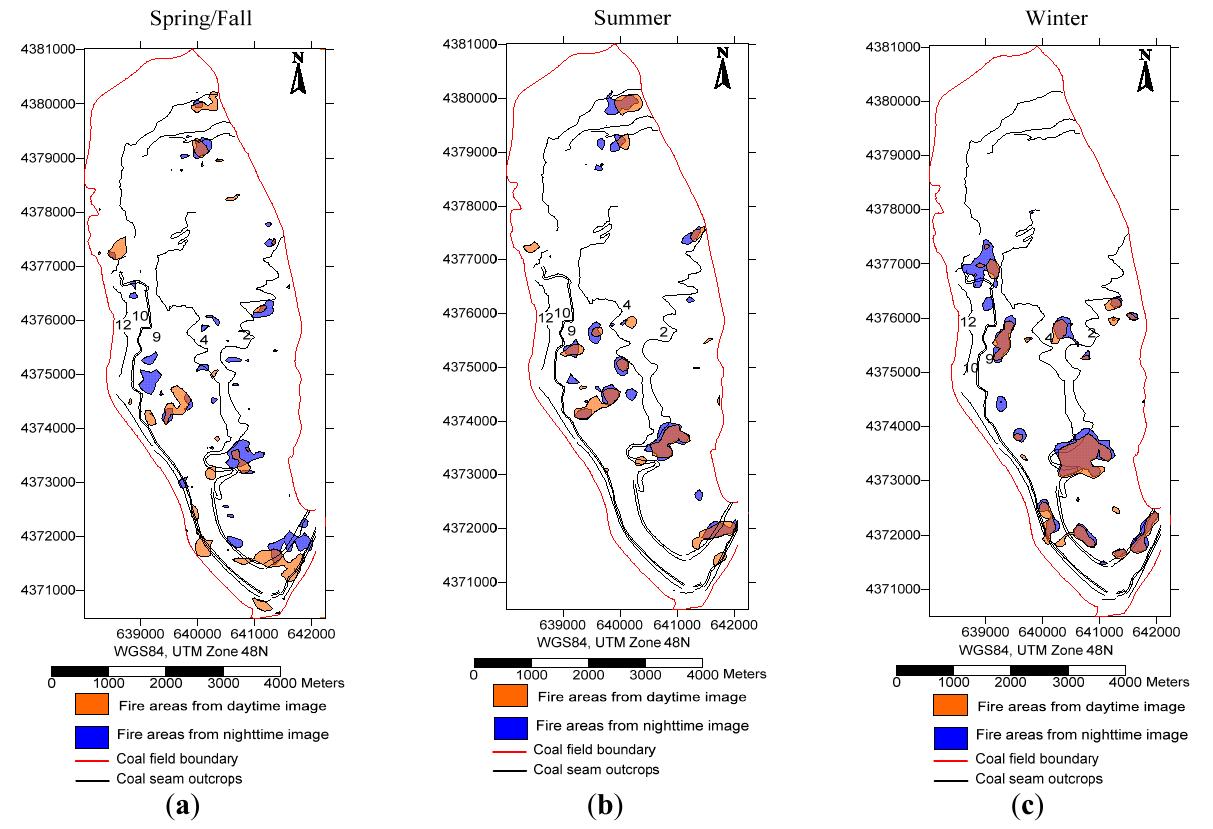
Figure 14. Coal fire areas retrieved from images acquired during daytime (orange areas) and nighttime (blue areas) for different seasons. Image pairs were acquired on ( a ) 27 March 2013; ( b ) 22 June 2013; and ( c ) 29 November